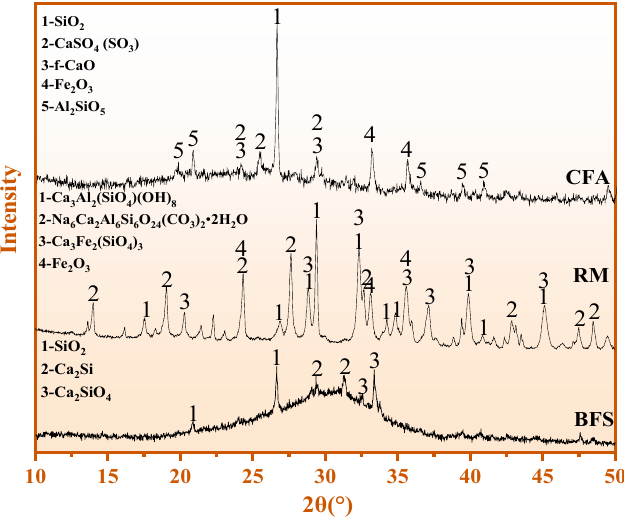
Figure 1. XRD results of RM, CFA, and BFS.